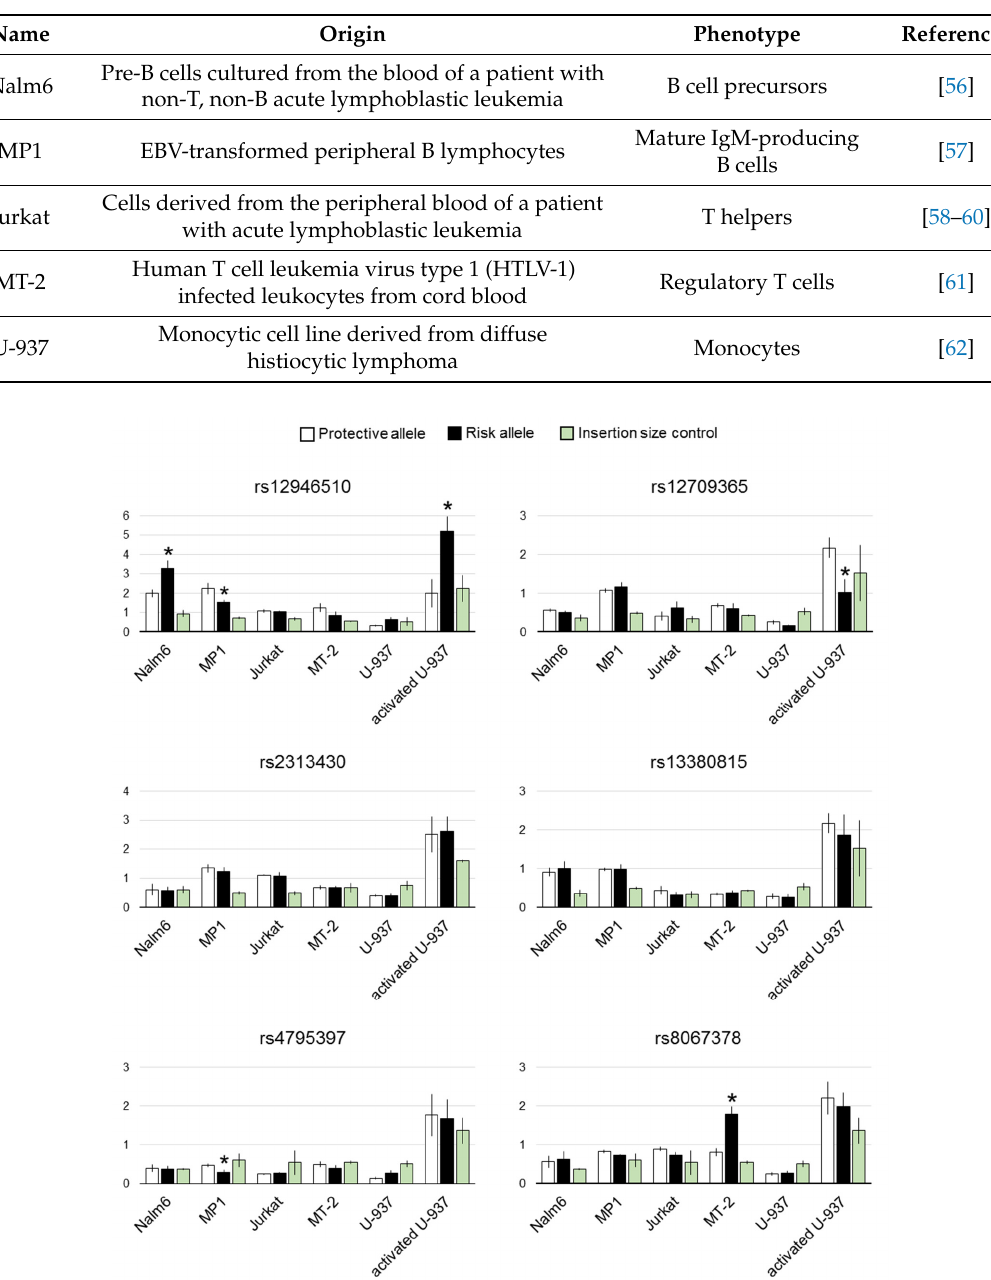
Table 7. Cell lines used for transfection.